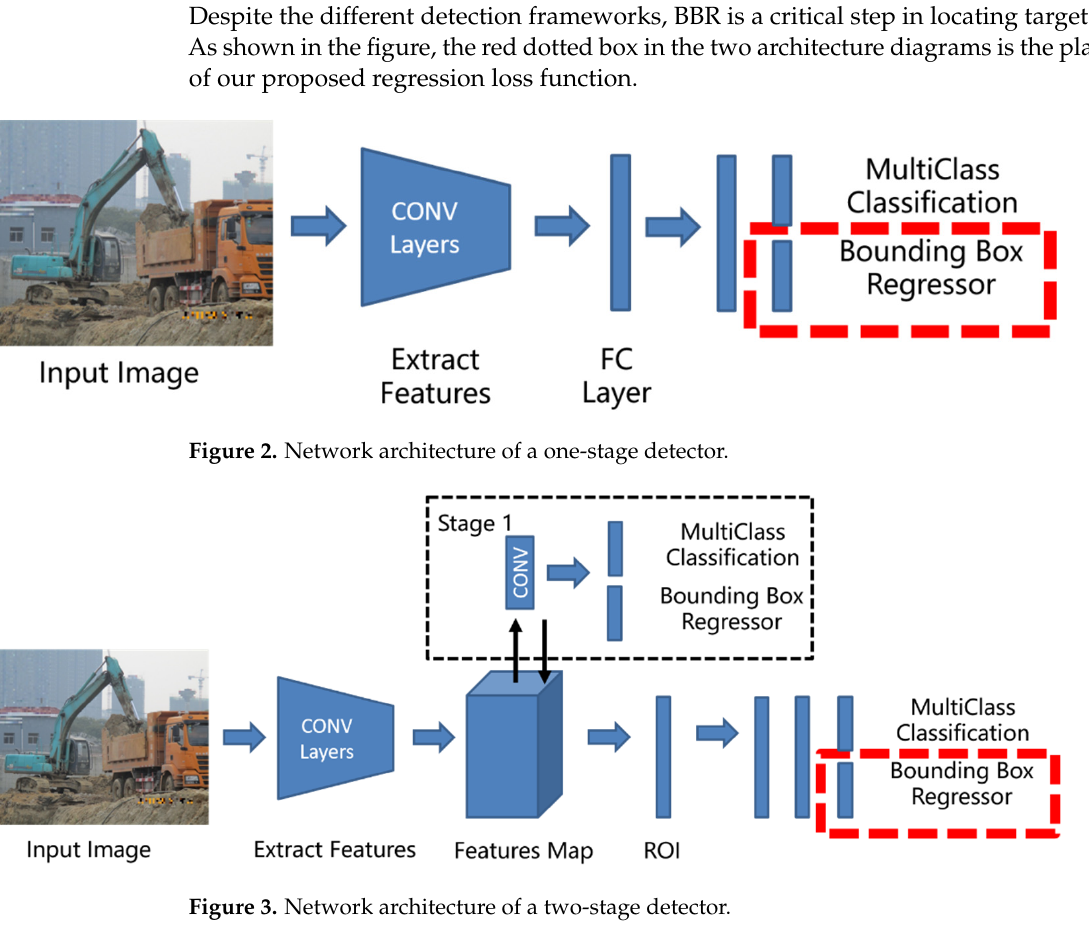
Figure 3. Network architecture of a two-stage detector.